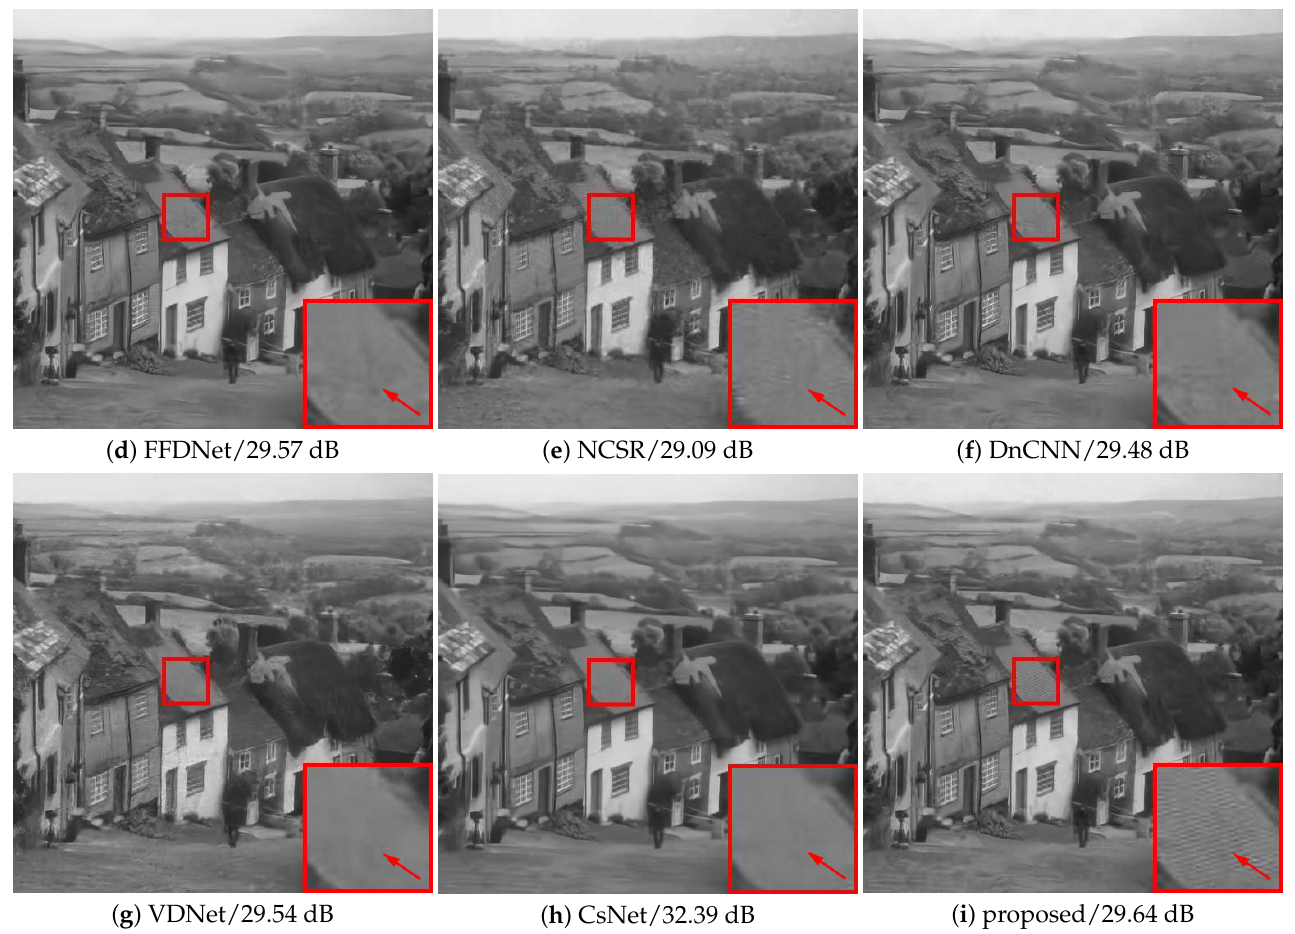
Figure 8. Denoising results of Hill image with noise level σ =